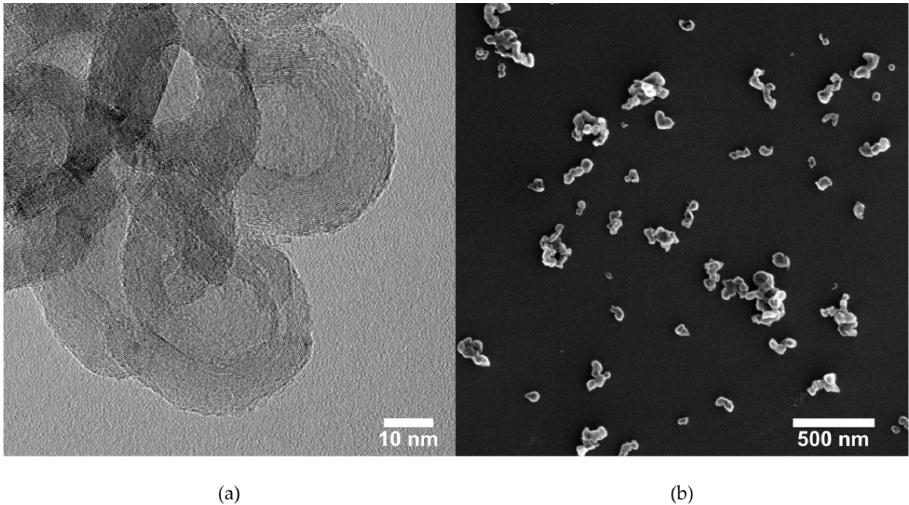
Figure 1. ( a ) Transmission and ( b ) scanning electron microscope images of MGNS particles.